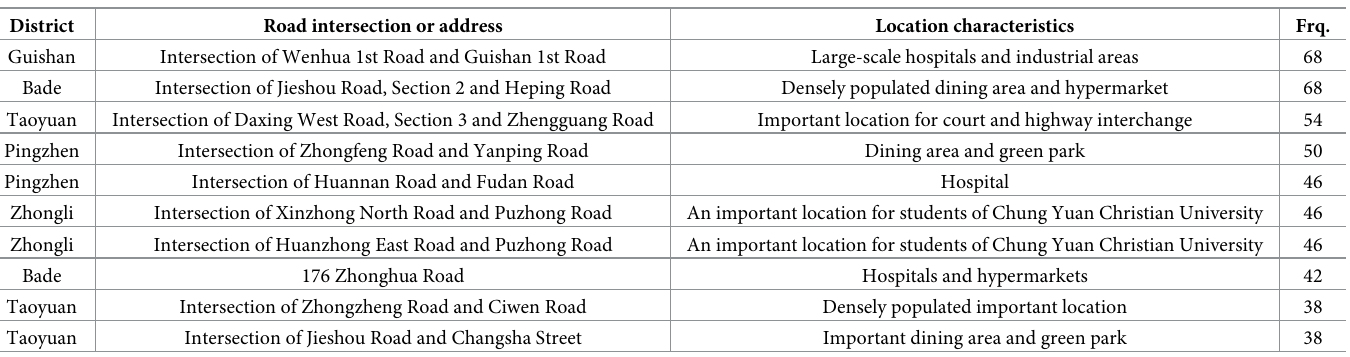
Table 5. Top 10 traffic accident locations in Touyuan